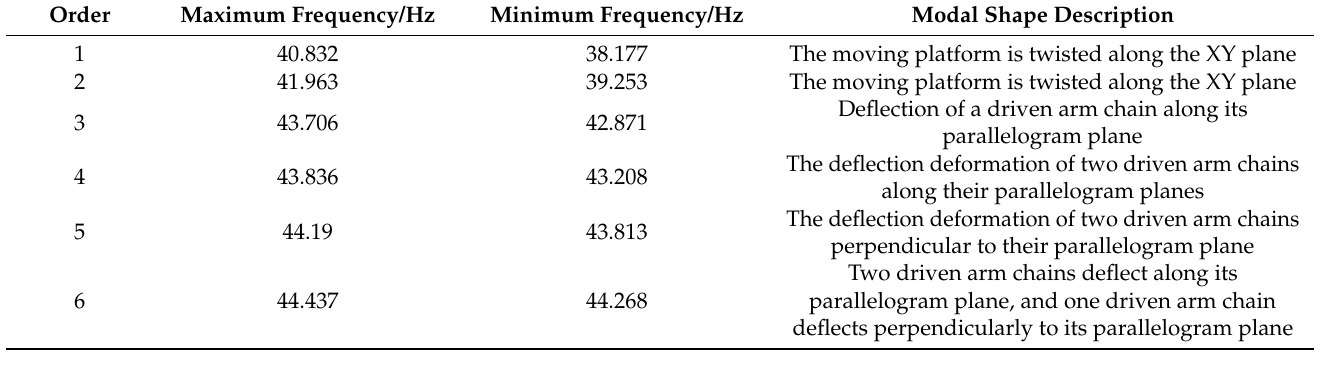
Table 4. Description of point vibration shapes of the robot at each position.